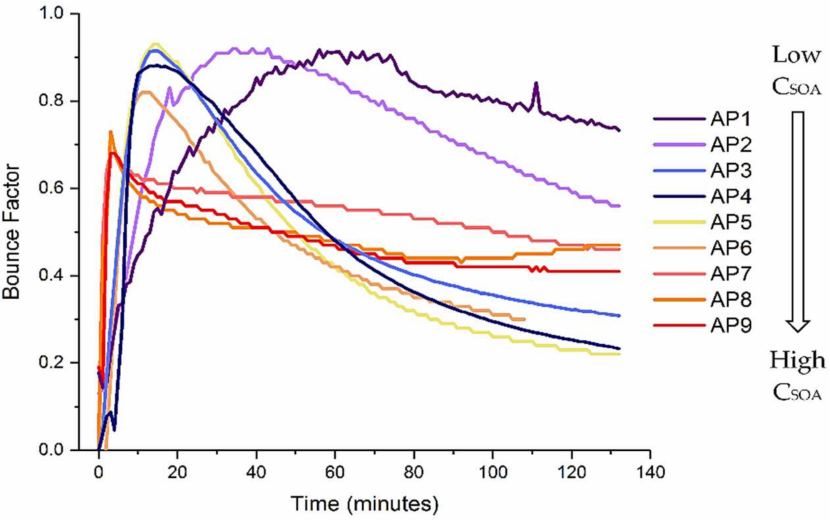
Figure 1. Calculated bounce factor (BF) for α -pinene derived secondary organic aerosol (SOA) as a function of time. Colors indicate different C SOA as shown in Table